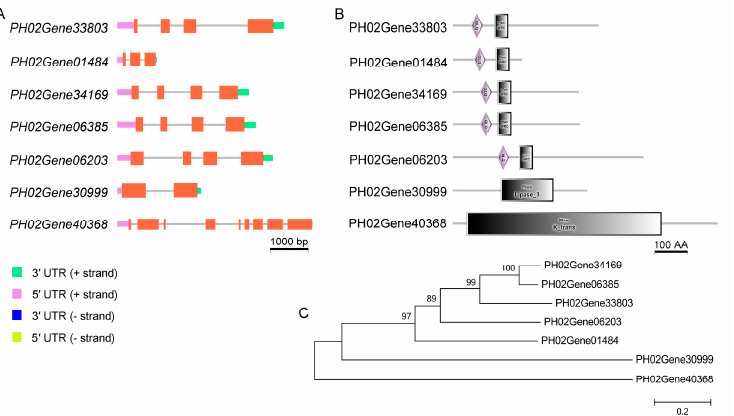
Figure 4. MicroR396s and their predicted targets in seedlings of Moso bamboo. ( A ) Shown are the sequences of microR396s, a protein kinase gene, and seven class III HD‑ZIP genes; ( B ) Shown are the Class III HD‑ZIP genes encoding proteins with a MEKHLA domain at the N‑terminal, a HOX domain at the C‑terminal, and a START domain; ( C ) Shown is a diagram representing the relationship among the seven target genes. Boxes symbolizes exons, lines represent introns, and the coding sequences represent three structural domains MEKHLA, HOX, and START. Shown below these domains are the sequences of the binding sites of miR396s to its seven targets. The bar equals 100 amino acid residues.